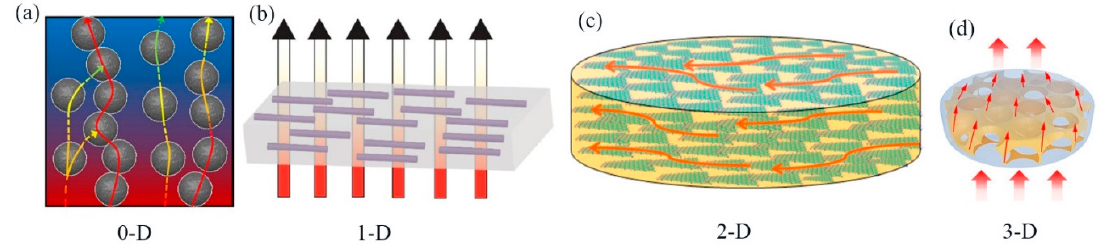
Figure 1. Thermal networks of ( a ) 0-D, ( b ) 1-D, ( c ) 2-D, and ( d ) 3-D fillers (reproduced with permission from [94–97]).